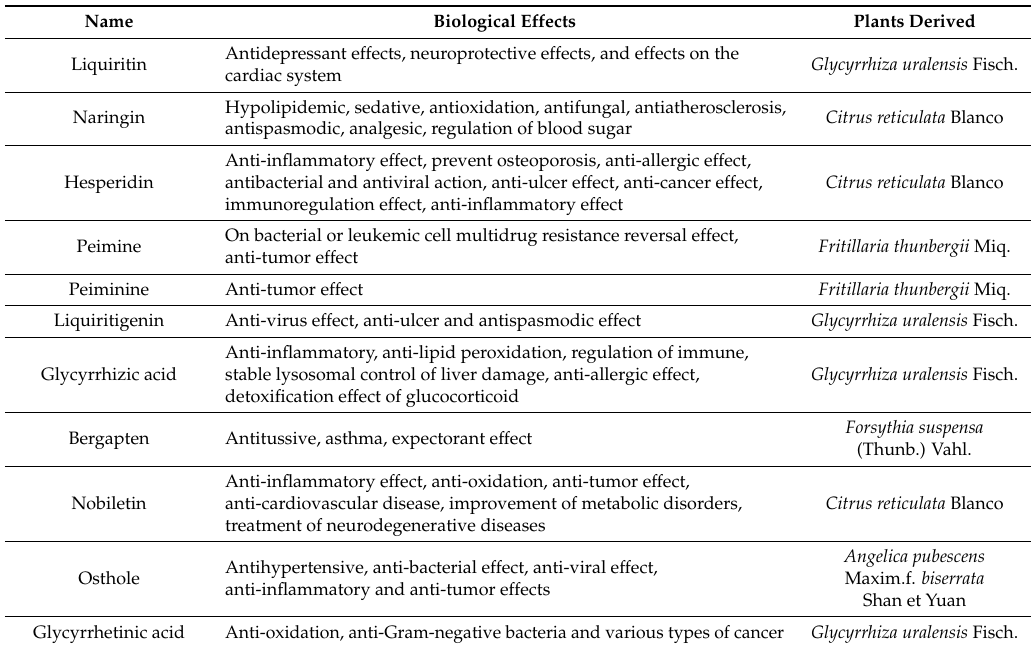
Table 1. Information about the eleven analyzed